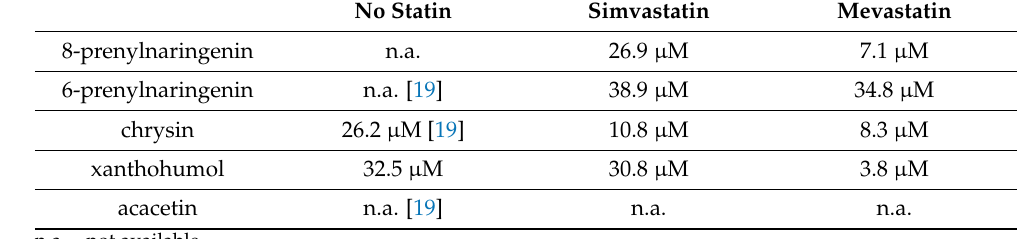
Figure 3. Jurkat T cells survival in the presence of simvastatin and mevastatin. Table 2. IC 50 of flavonoids and flavonoids applied with statins (simvastatin or mevastatin) deter- mined in Jurkat T cells.